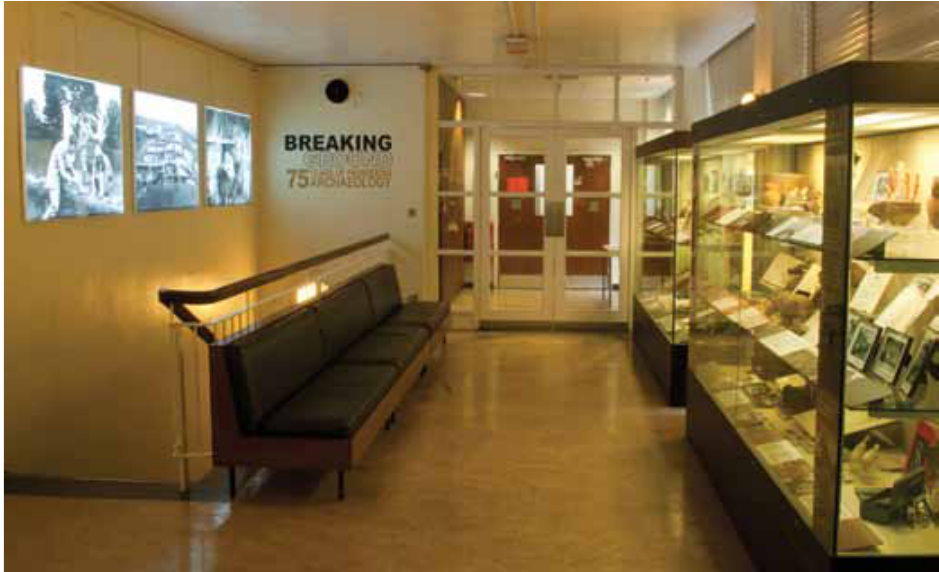
Fig. 1: The exhibition in the A.G. Leventis Gallery of the UCL Institute of